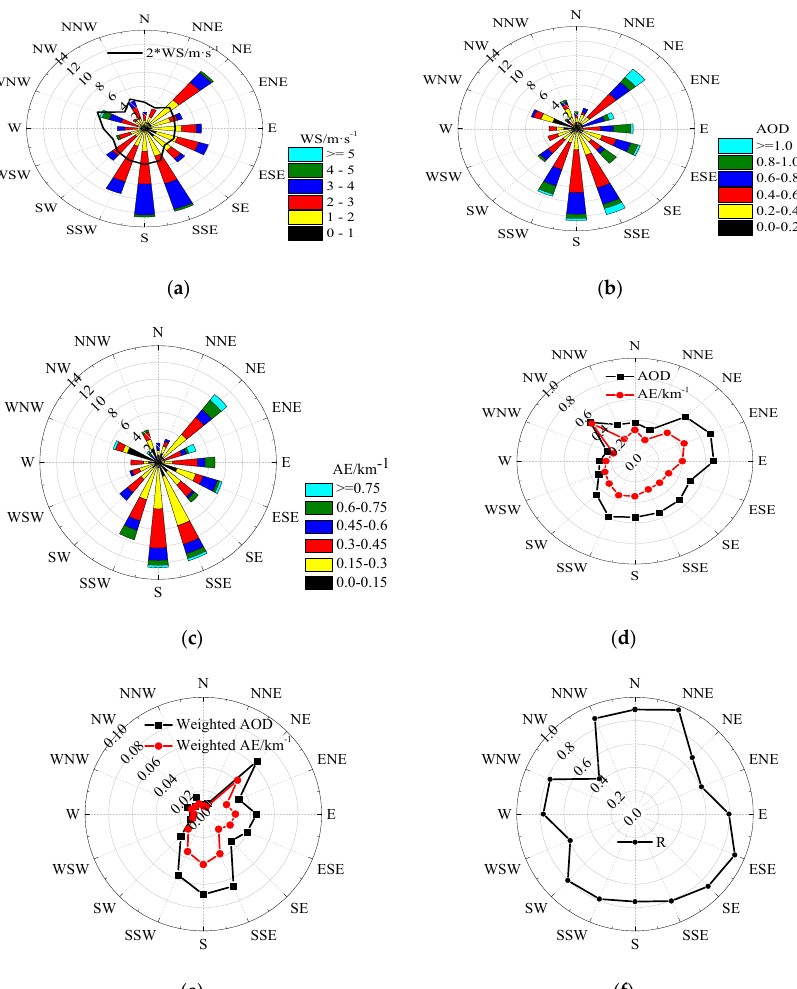
Figure 5. Roses for hourly wind, AOD and near-surface AE: ( a ) rose for wind frequency (color blocks; unit: %) and wind speed (WS, black line, scaled by factor 2) in 16 wind direction sectors; roses for ( b ) AOD and ( c ) near-surface AE frequency (unit: %); ( d ) averaged AODs and AEs, and ( e ) they are weighted by the wind frequency in 16 wind direction sectors; ( f ) correlation coefficient (R, black curve with dots) between AOD and AE, respectively, on 16 wind directions.